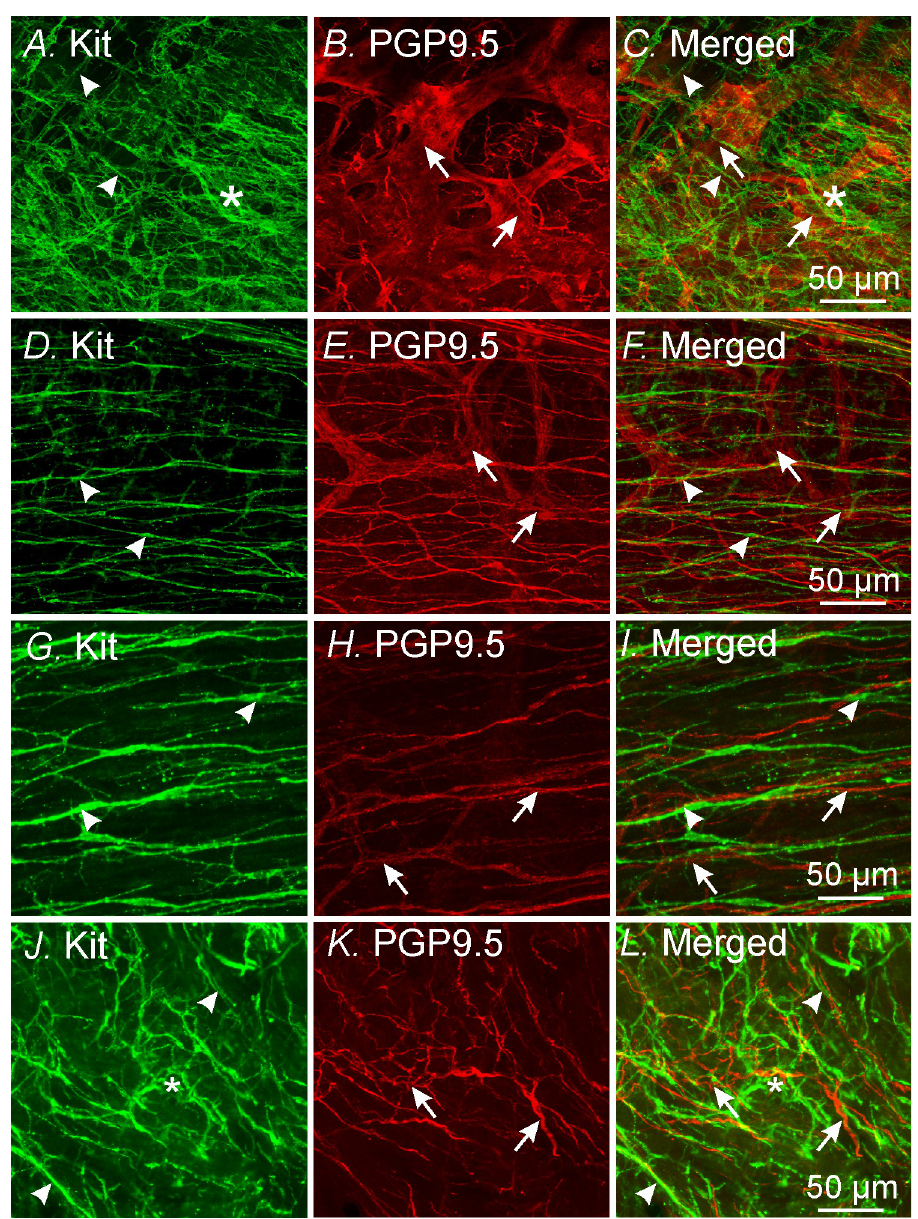
Fig 12. Immunohistochemical labeling of ICC and enteric nerves following VSG. Panels A-C, double labeling of Kit + ICC at the level of the myenteric plexus ( A ; � ) and intramuscular ICC (arrowheads, green). B, PGP9.5 + enteric nerve ganglia and fibers (arrows, red), in control gastric antrum tissues. Merged image is shown in Panel C . Panels D-F, double labeling of Kit + ICC-IM ( D; arrowheads, green) and PGP9.5 + enteric nerves ( E; arrows, red), including the myenteric plexus, 1-week post-surgery. Note the absence of ICC-MY at the level of the myenteric plexus. Merged image is shown in Panel F. Panels G-I, 3-weeks after surgery ICC-MY were still disrupted or absent, whereas ICC-IM ( Panel G ; arrowheads) and enteric nerves ( Panel H ; arrows) were evident. Panel I , merged image of panels G&H . Panels J-L, 4 months post-surgery ICC-MY networks had recovered ( � , green Panel J ). ICC-IM (arrowheads) were also evident. Panel K , PGP9.5 + enteric nerves (red; arrows) were widely distributed within the circular muscle layer. Merged image is shown in panel L . Scale bars in Panels C,F,I&L = 50 μ m and applies to their respective panels.